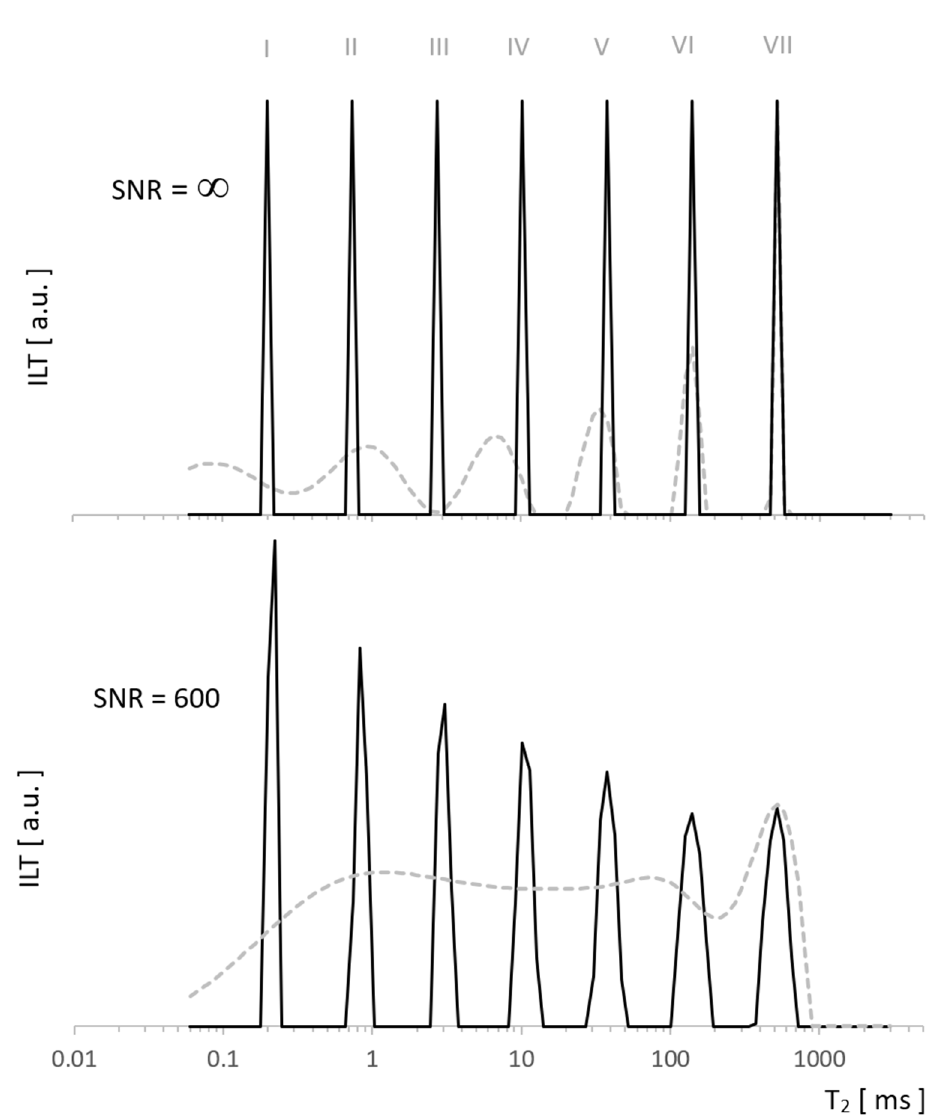
Figure 2. Spectra of the test signal with T 2 distribution as seven Kronecker deltas. Obtained using ILT with L-Curve regularization (solid line) vs. other regularization method (dashed line) for noiseless data (upper figure) and for SNR = 600 (lower figure). Significant differences in the resolution resulted from the use of different regularization